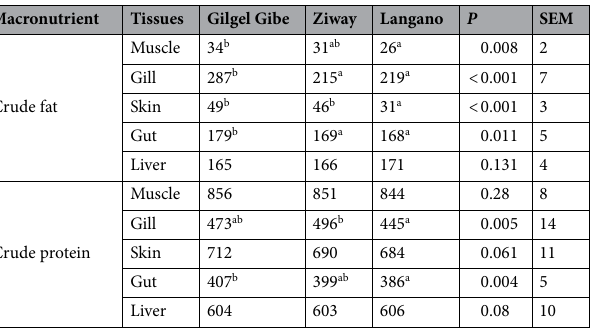
Table 3. Crude fat and crude protein content of Nile tilapia tissues from three lakes in Ethiopia (g/kg on dry matter basis). Different superscripts within a row indicate significant differences at P < 0.05.